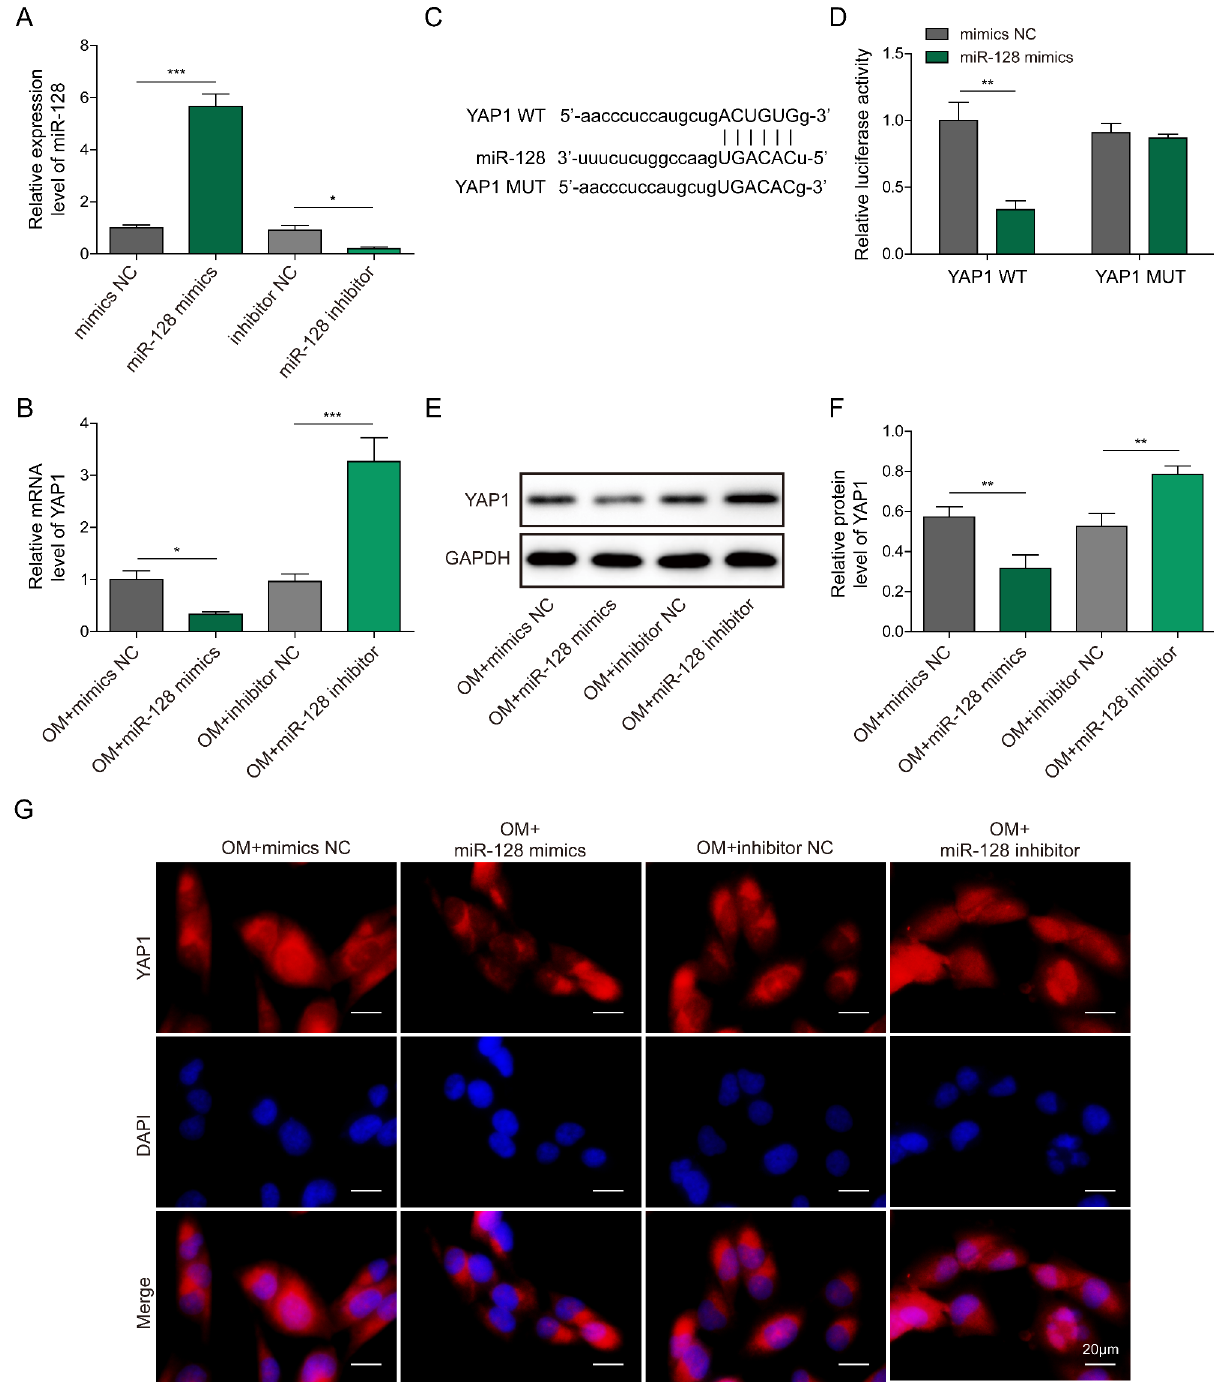
Fig. 7 YAP1 is a downstream target gene of miR-128. (A) miR-128 and (B) YAP1 expression in BMSCs transfected with miR-128 mimics or miR-128 inhibi- tor was detected by qRT-PCR. (C) Starbase database was adopted to predict the binding sites of miR-128 to YAP1 3 ′ UTR. (D) The interaction between miR-128 and YAP1 was analyzed by dual-luciferase reporter assay. (E&F) Western blotting analysis of YAP1 protein levels in BMSCs after transfection with miR-128 mimics or miR-128 inhibitor. (G) Immunofluorescence staining analysis of the subcellular distribution of YAP1 in BMSCs. * P < 0.05, ** P < 0.01 and *** P <